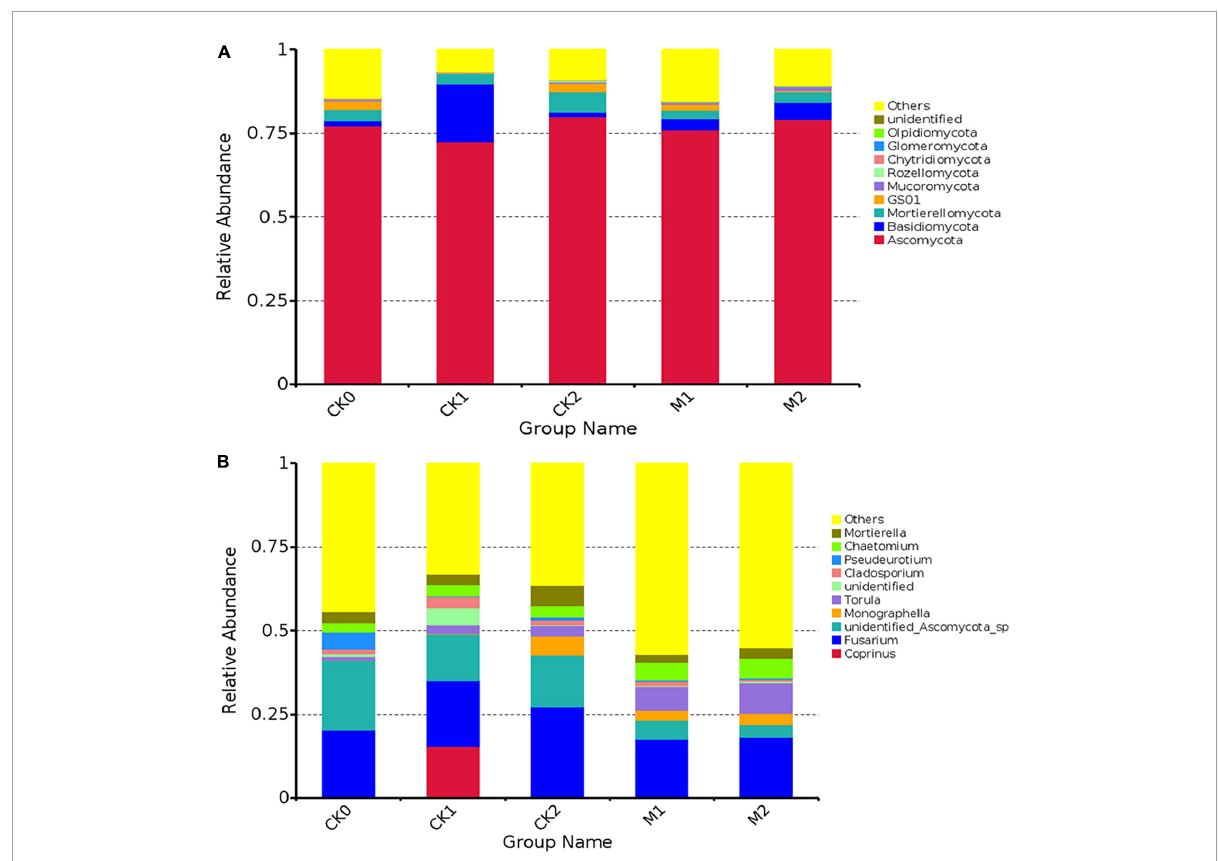
FIGURE3 The composition of the fungal community at phylum level (A) and genus level (B) in the five types of samples. The 10 species with the highest abundance at the phylum or genus level were selected for each sample type. “Others” represents the sum of the relative abundances of all other phyla (genera) other than these 10 phyla or